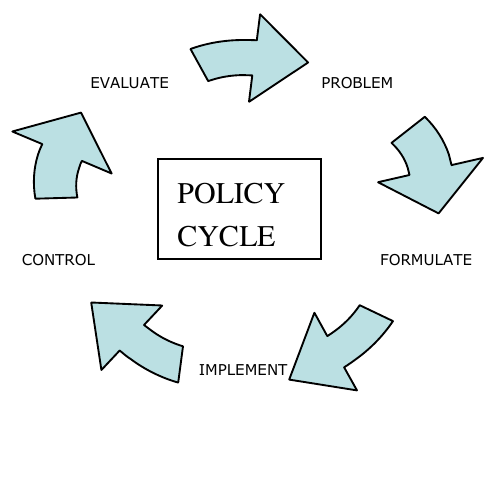
Figure 1. Scheme of a policy cycle.